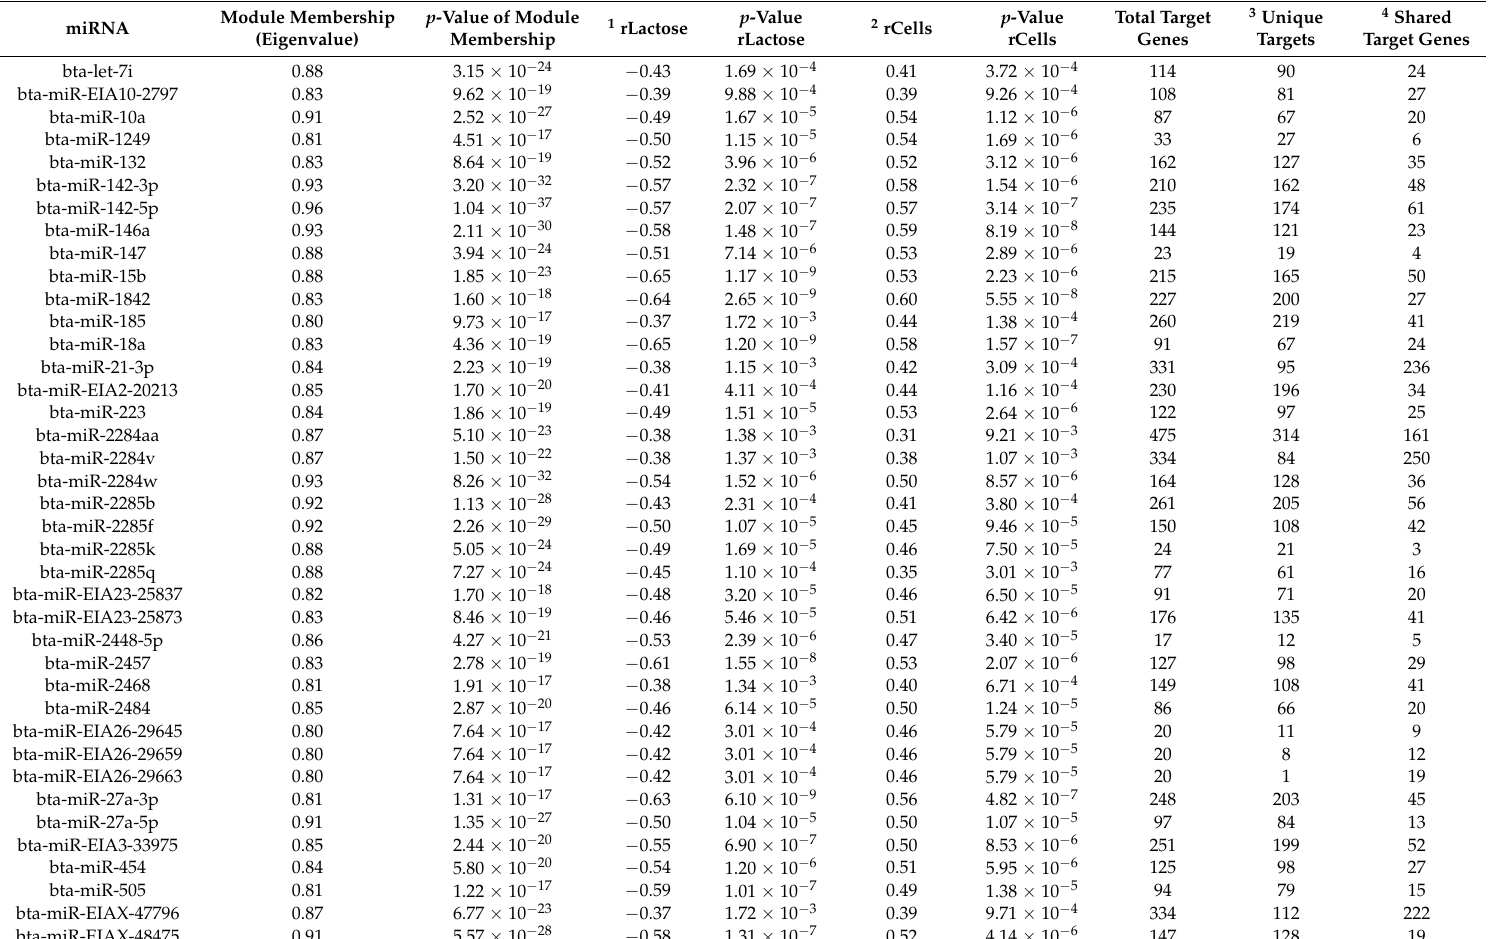
Table 5. miRNAs in the TUQUOISE module, their correlation coefficients with lactose and somatic cell count, and predicted target